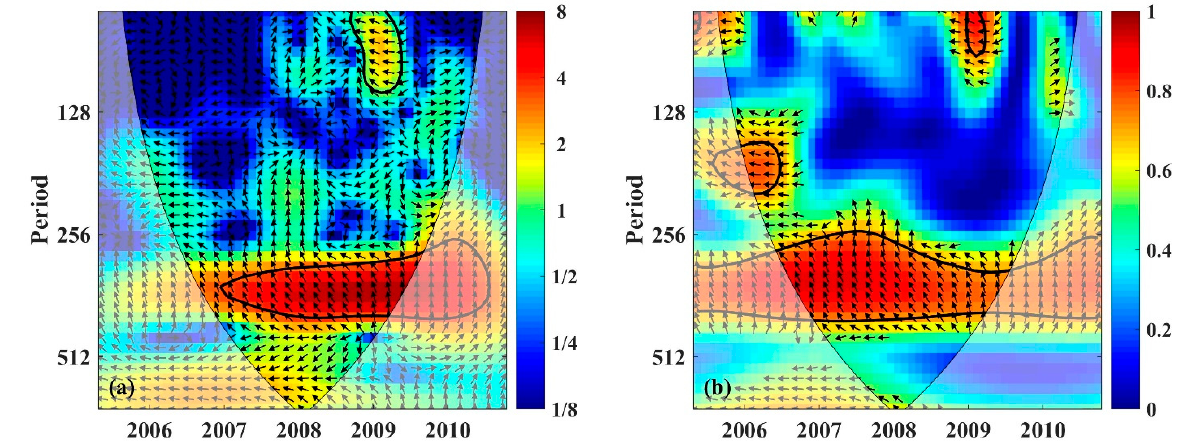
Figure 8. Cross wavelet transform ( a ) and squared wavelet coherence ( b ) of the InSAR deformation and precipitation time series. The 5% significance level against red noise is shown as a thick contour.